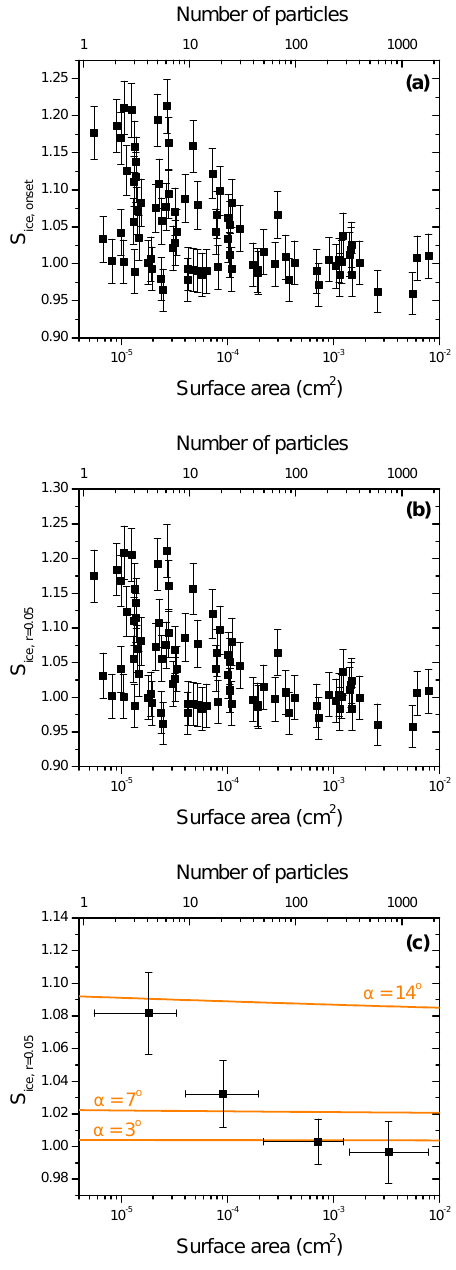
Fig. 3. Results for kaolinite particles: (a) individual onset measure- ments, (b) individual S ice ,r = 0 . 05 results and (c) average S ice , r = 0 . 05 . The average values are calculated for four equally sized bins and the horizontal error bars show the range of data points in each bin. The surface area values in (c) represent the average surface area of the points in each bin. Error in S ice , onset is given as experimental er- ror in measurements of saturation. Error in S ice , r = 0 . 05 is based on the difference between S ice , onset and S ice , previous as well as the un- certainty in measuring S ice , onset . Error in the average S ice , r = 0 . 05 represents the 95% confidence interval. Predictions are shown us- ing the single- α model (orange lines) calculated using Eq. (9). In addition to surface area, the corresponding number of particles cal- culated from A average is also